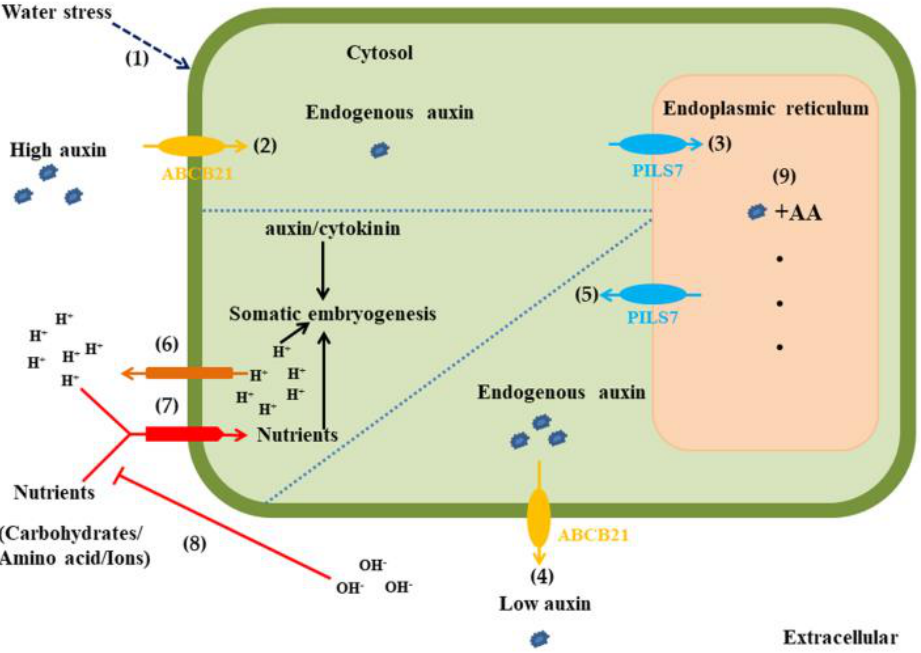
Figure 10. Hypothetical schematic of somatic embryogenesis mediated by auxin transport in Lilium pumilum . (1) Water stress activates somatic cells to regain totipotency. (2) ABCB21 transports auxin into the cytosol. (3) PILS7 couples auxin in the endoplasmic reticulum. (4) ABCB21 transports auxin to the extracellular space. (5) PILS7 releases auxin into the cytosol. (6) High H + -pumping activity occurs. (7) High H + influx occurs. (8) High pH inhibits nutrient transport. (9) Auxin is coupled with amino acids. Solid arrows indicate transport direction; Dotted arrow indicates exogenous stimulus; T-bars indicates transport suppression.